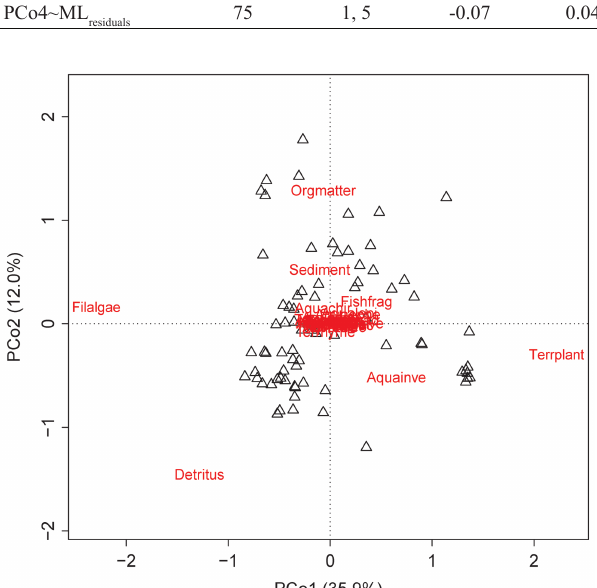
Fig. 2. Principal Coordinate Analysis (PCoA) showing PCo1 and PCo2 based on Bray-Curtis dissimilarities of diet composition of 75 individuals of the stream-dwelling characid Deuterodon stigmaturus . Food items name abbreviations are listed in Table 3.